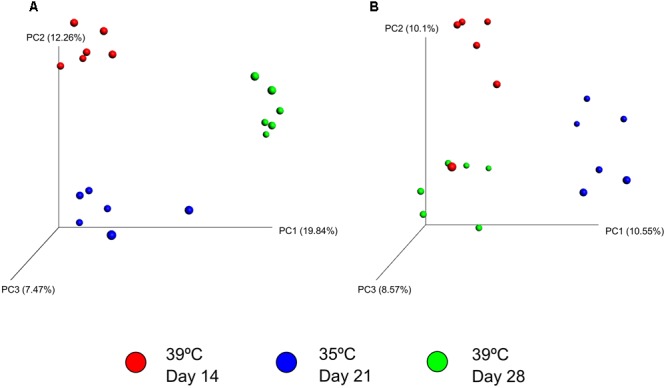
Principal coordinate analysis (PCoA) of the unweighted UniFrac distances for (A) LAM samples and (B) SAM samples for each sampling day and incubation temperature. The percent variation explained by each principal coordinate is indicated on the axes. Original rumen samples are excluded. LAM, liquid-associated microbes; SAM, solid-associated microbes. N = 6 for each sample type, sampling time and incubation time.